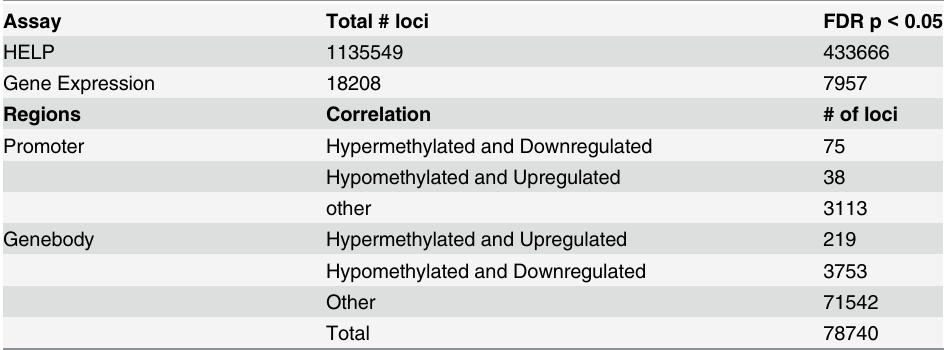
Table 2. Merge of Differential Methylation and Differential Expression (All Histologies – 21 pairs). All Histologies (21 pairs).